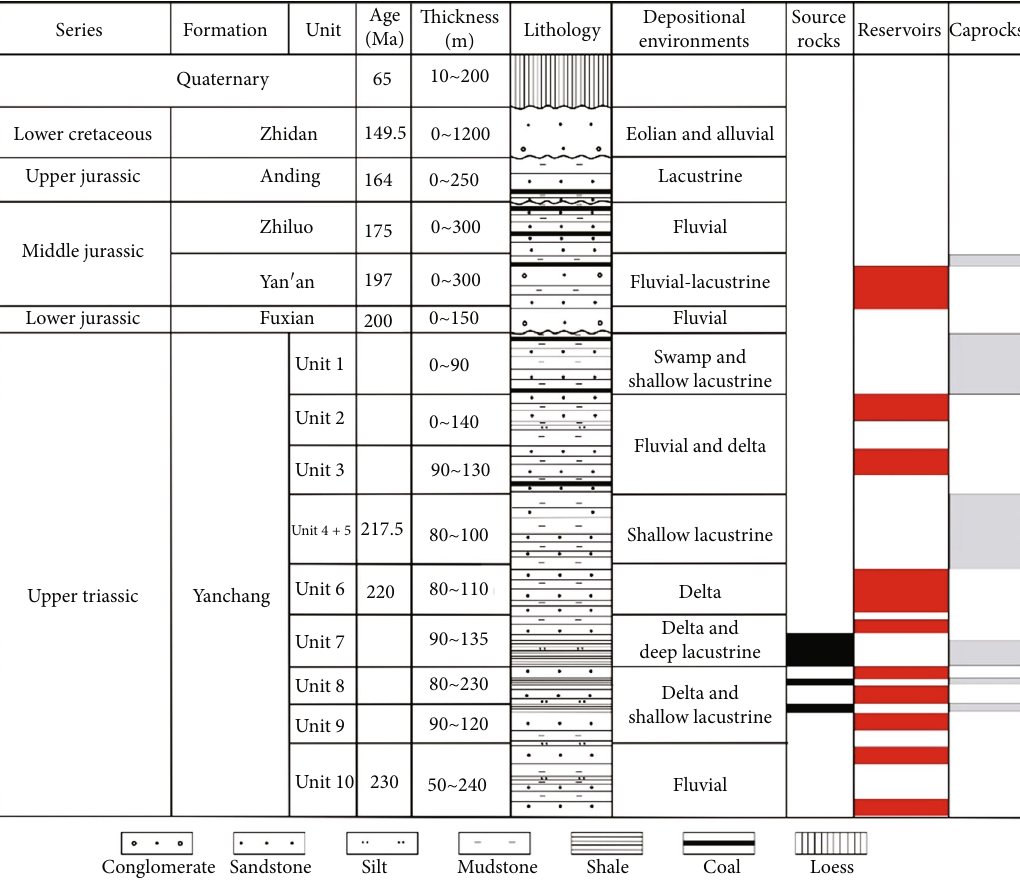
Figure 2: Lithological columnar section of study